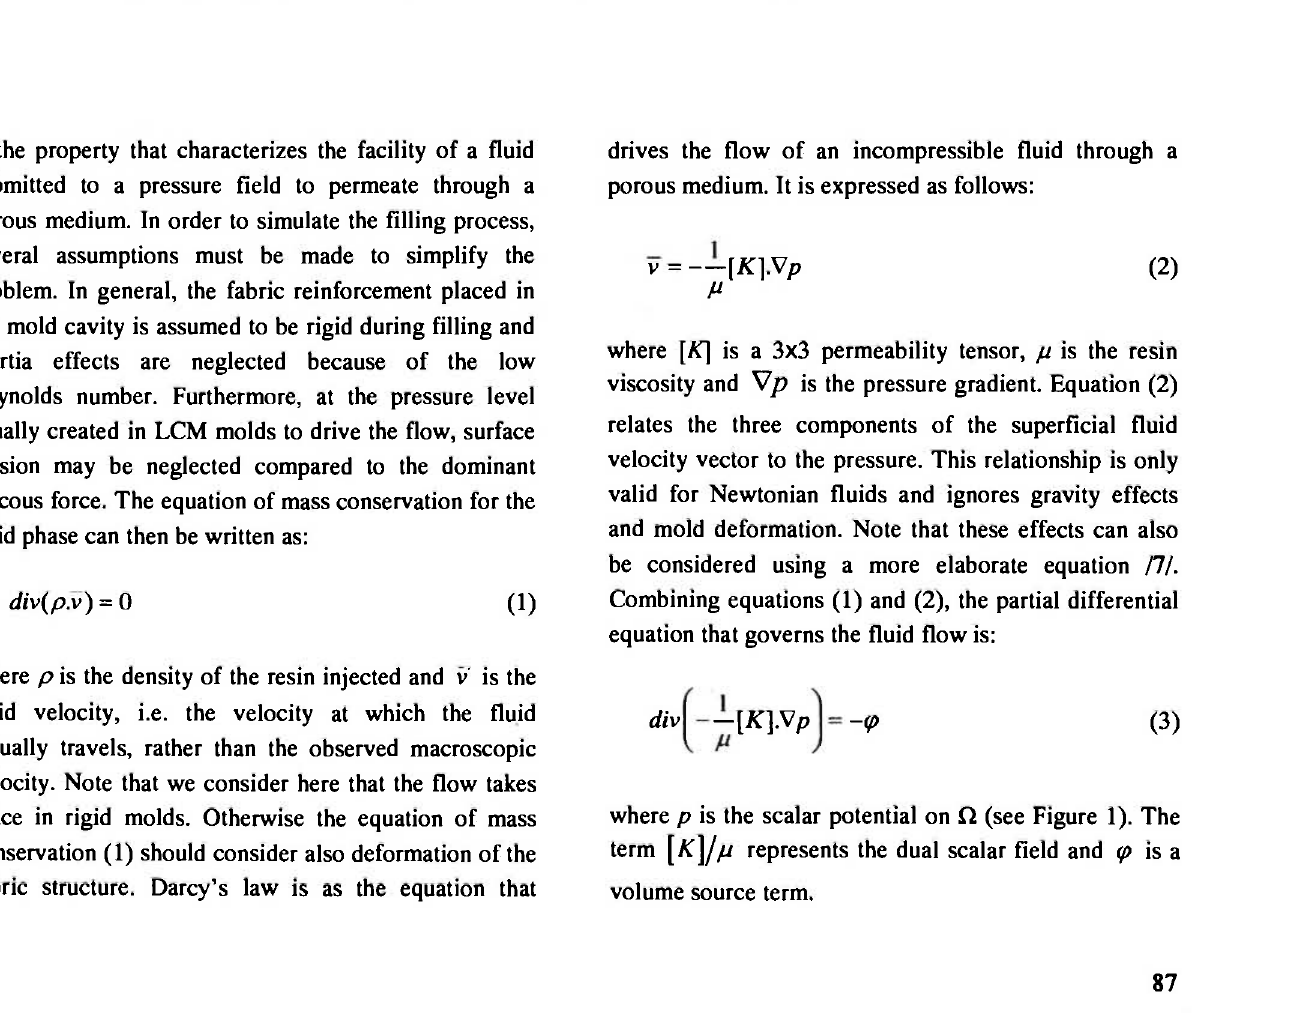
Fig. 1: Schematic representation of the domain Ω representing the mold cavity. The boundary is defined by dQ = r uT u T . (Note that Γ^ was deliberately removed for q p d